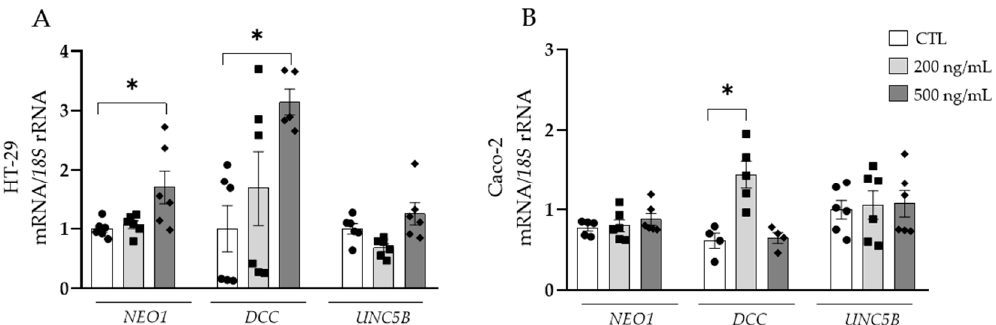
Figure 4. Gene expression levels of neogenin-1 ( NEO1 ) deleted in colorectal carcinomas ( DCC ) and uncoordinated-5 homolog family member B ( UNC5B ) in ( A ) HT-29 and ( B ) Caco-2 human colorectal cancer cell lines after the treatment with netrin-1 (NTN-1) for 24 h. Gene expression levels in untreated cells were assumed to be 1. Values are the mean ± SEM (n = 4–6 per group). Differences between groups were analysed by one-way ANOVA followed by Dunnett’s post hoc tests. * p < 0.05.